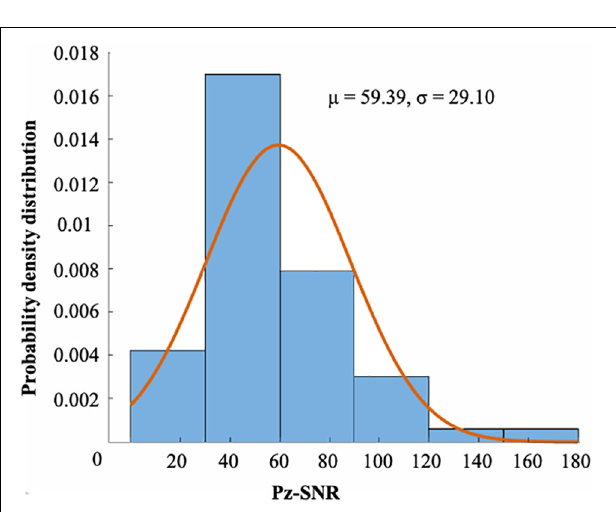
FIGURE 5 | The distribution of the SNR of Pz channel ( µ = 59.39, σ = 29.10). There were 55 runs of 28 subjects. There was no significant difference between the distribution and the normal distribution by KS test ( p =